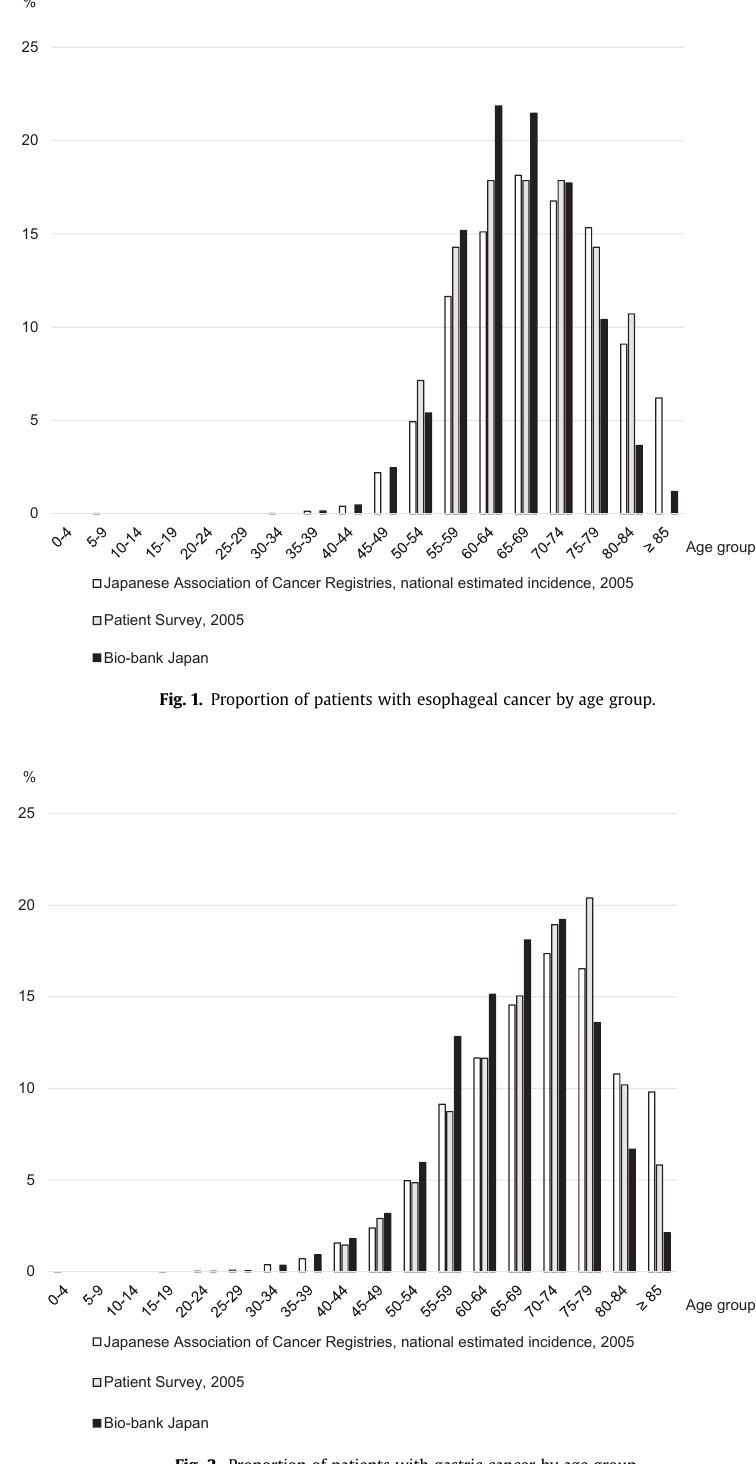
Fig. 2. Proportion of patients with gastric cancer by age